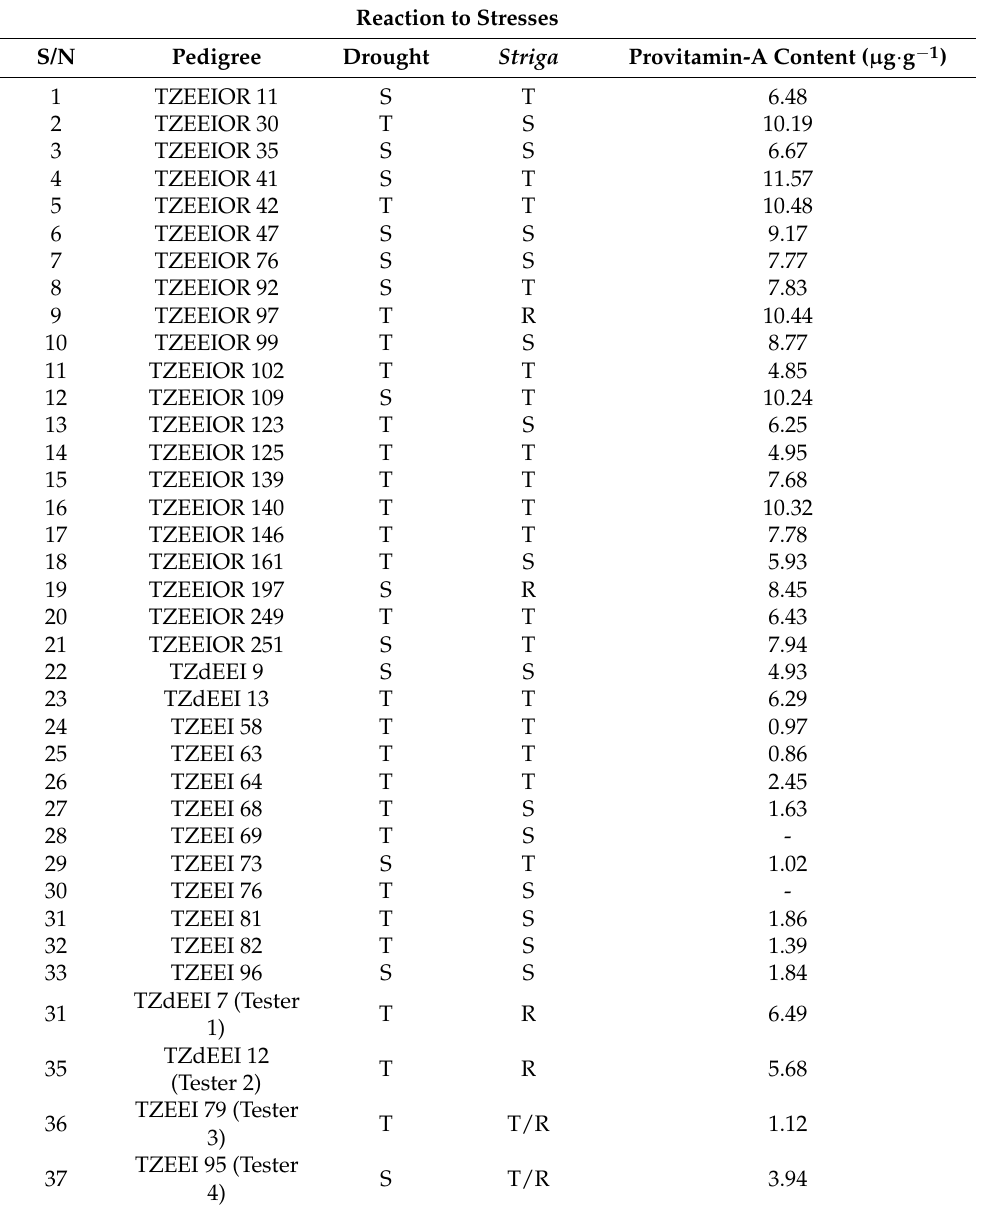
Table 1. Description of inbreds used in line × tester study: reaction to stresses and level of provitamin A